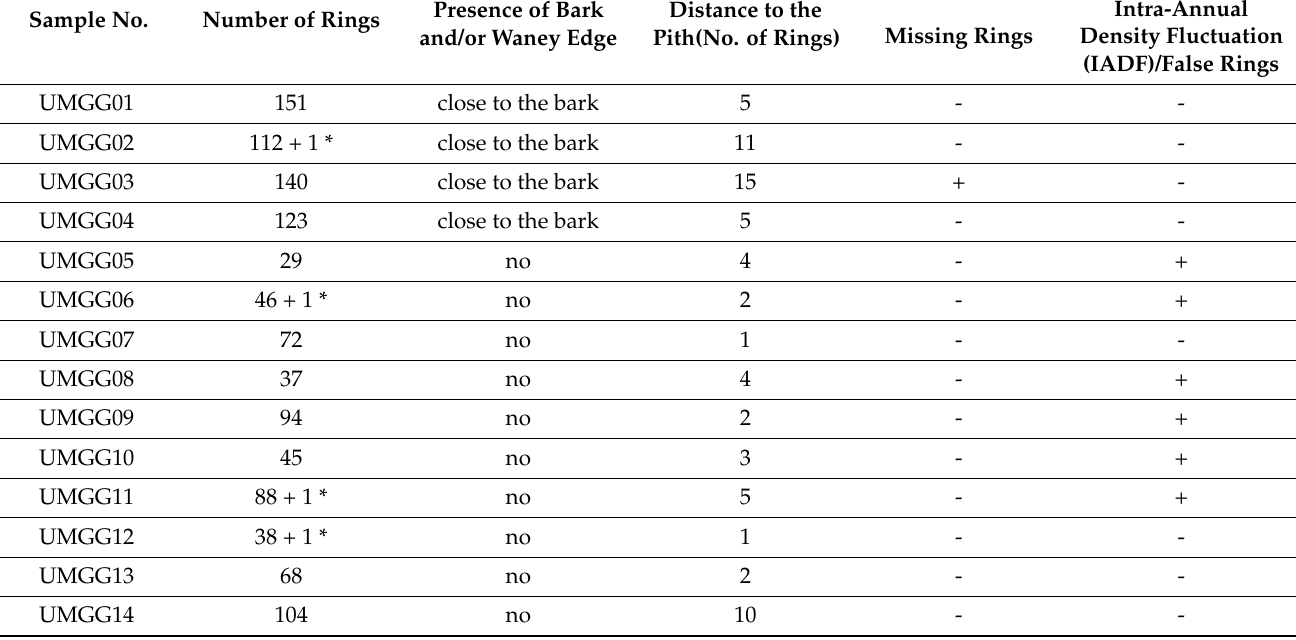
Table 2. Characteristics of wood and structure of samples collected in Gönpa Gang. 1 * for number of rings means that the outermost ring present in the sample is not fully preserved and therefore has not been measured. Distance to the pith was estimated based on curvature, using a geometric pith